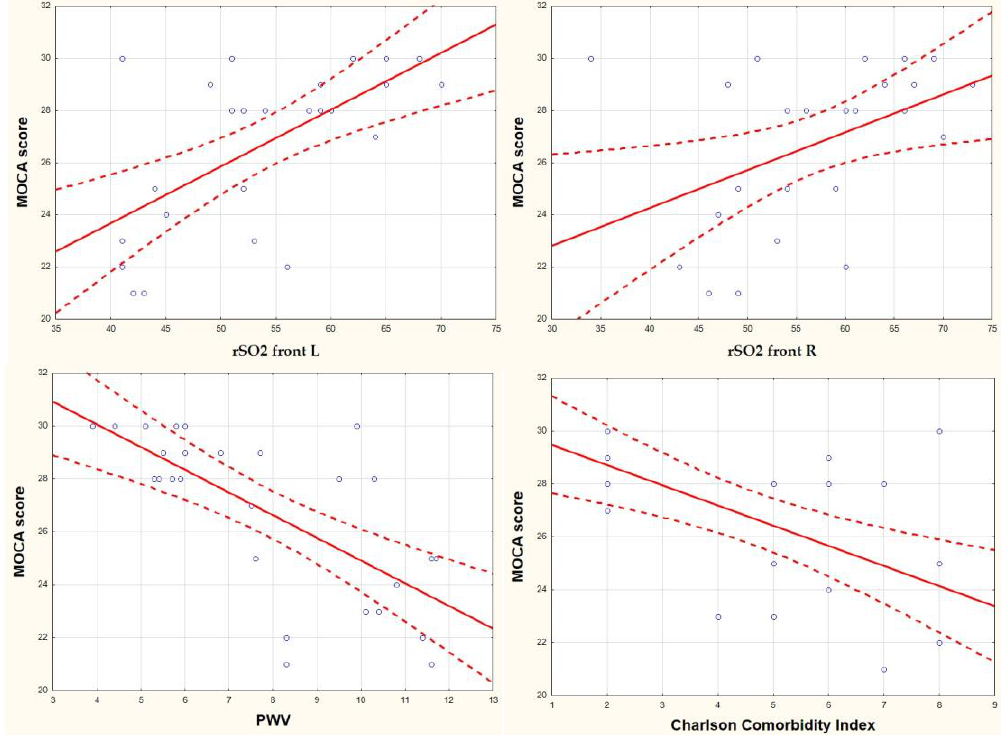
Figure 2. Correlation of the MOCA score with rSO2 front R, rSO2 front L, PWV, and CCI.